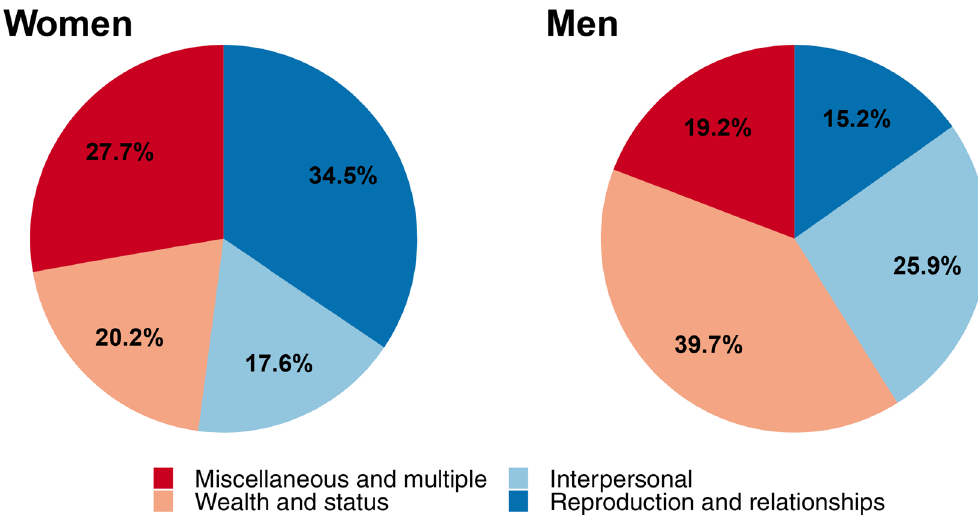
Figure 5. Pie chart showing how ethnographers depicted causes of accusations by sex. The categories are Reproduction and relationships: fertility problems, marriage, love, jealousy and adultery. Wealth and status: competition for political positions, disputes over property and inheritance, financial/political success. Interpersonal reasons: cases where the accused was viewed as difficult, arguments unrelated to previous categories and associated with personal slights, prior reputation as a ‘witch.’ Miscellaneous cases or Multiple causes. This category consists of ( a ) cases with no clear reason for a particular individual being identified as a witch; perhaps sometimes solely an explanation for an unfortunate event and ( b ) cases where the causes of an accusation were a combination of the main